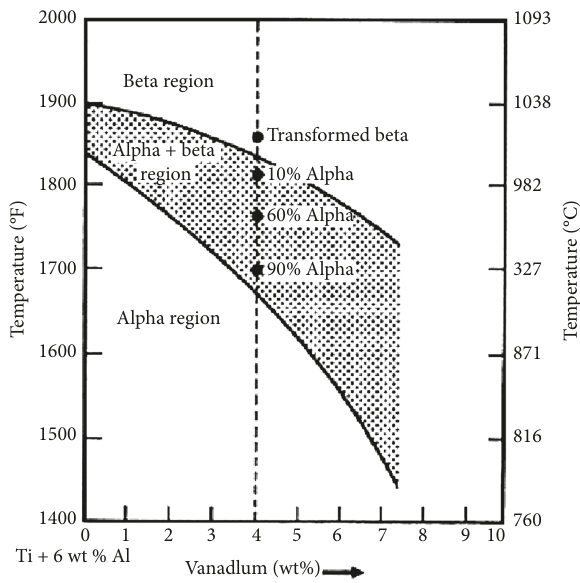
Figure 1: Ti6Al4V phase diagram